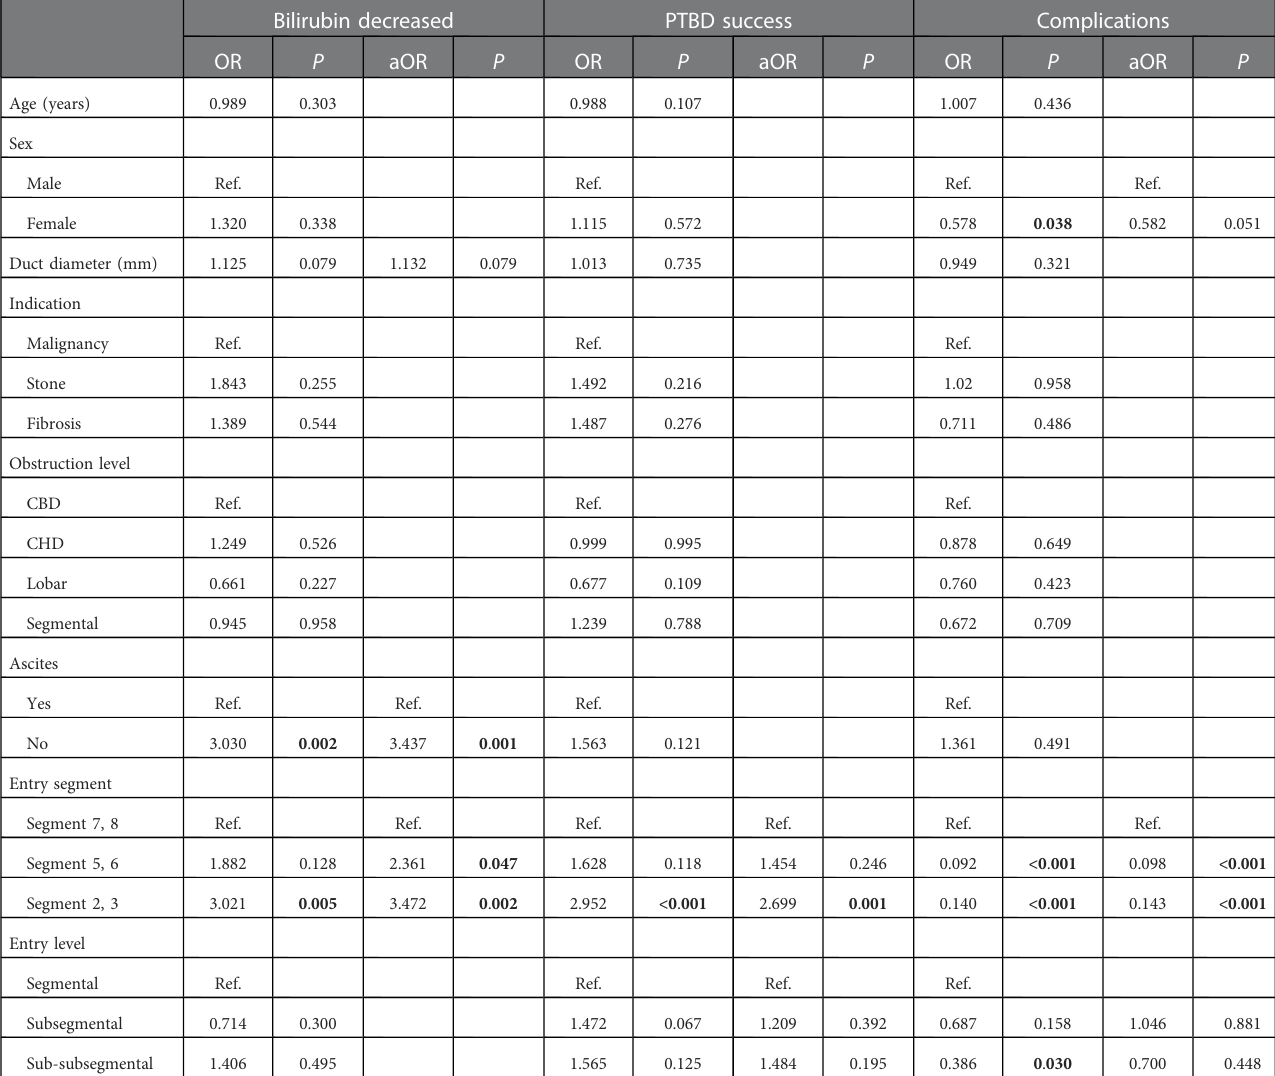
TABLE 3 Logistic regression analysis of factors associated with PTBD success, bilirubin reduction, and